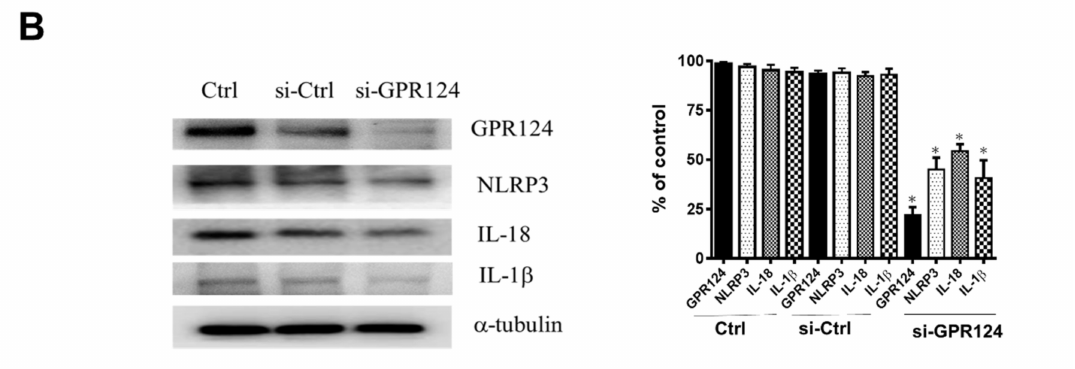
Figure 6. The protein expression of NLRP3, IL-18, and IL-1 β inflammasome in spontaneous miscar- riage compared to normal pregnancy. Human primary endometrial stromal cells were transfected with miR-138-5P (25 nM) and si-GPR124 (50 nM) for 48 h. Immunoblot analysis was performed to examine the protein levels of GPR124, IL-1 β , IL-18, and NLRP3. ( A ) The expressions of GPR124, NLRP3, IL-18 and IL-1 β protein regulated by miR-138-5p in endometrial stromal cells. ( B ) The expressions of GPR124, NLRP3, IL-18 and IL-1 β protein regulated by si-GPR124 in endometrial stromal cells. miRNA negative control (miR-NC). siRNA control (si-Ctrl). (* p < 0.05, versus